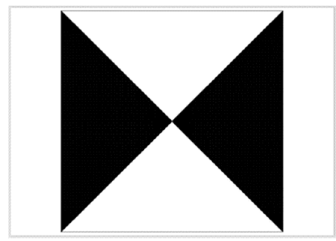
Figure 2. The target.